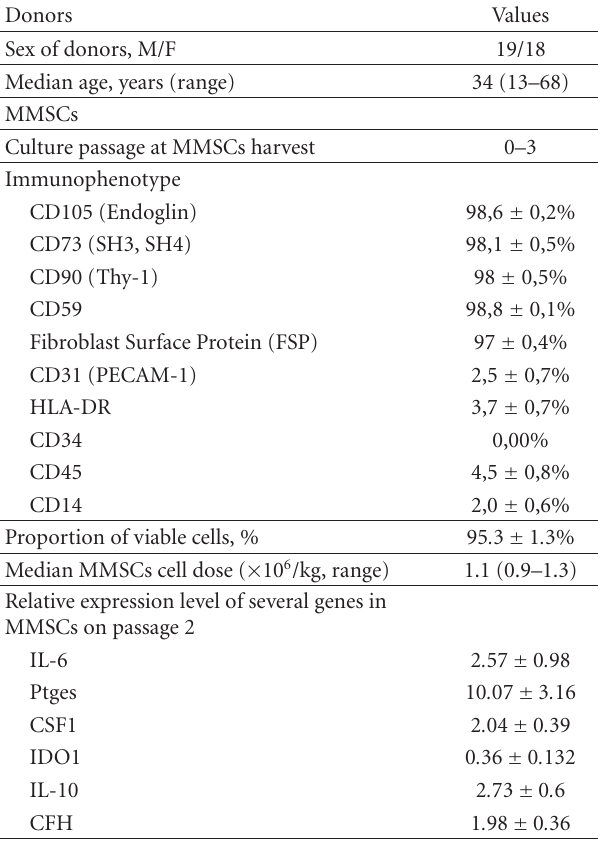
Table 2: MMSC donor and graft